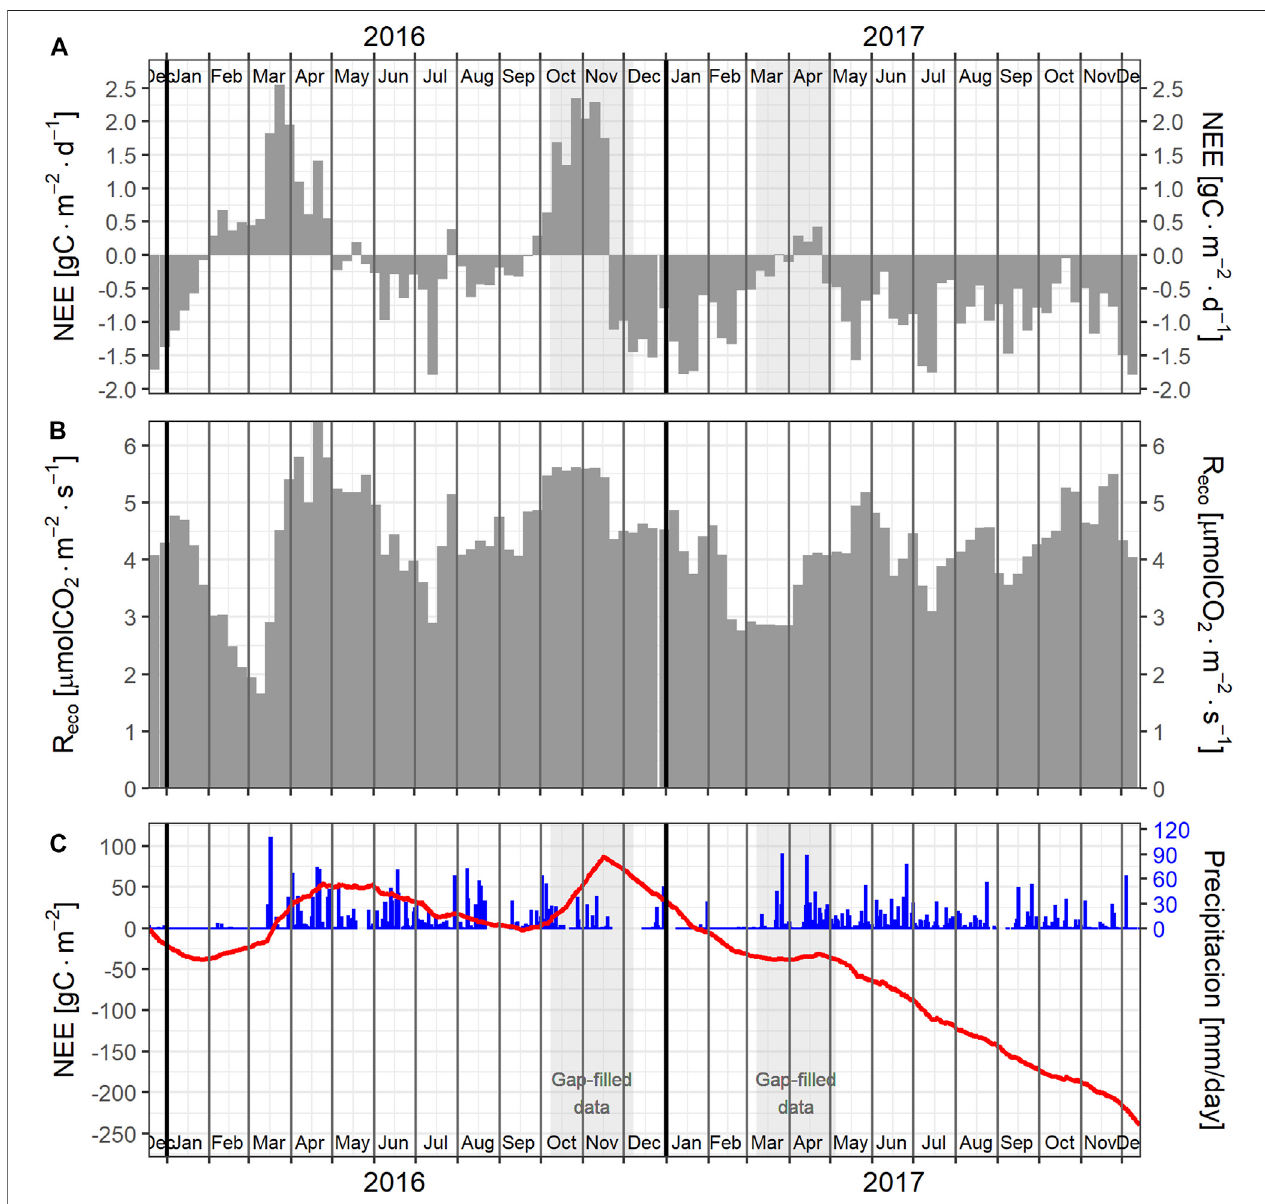
FIGURE4| Carbon fl uxes,ecosystemrespiration,andcumulativeNEE. (A) Weeklyaverageofdailycarbon fl uxes, (B) weeklyaverageofecosystemrespiration, (C) cumulative NEE since the beginning of measurements (red) and daily precipitation (blue).